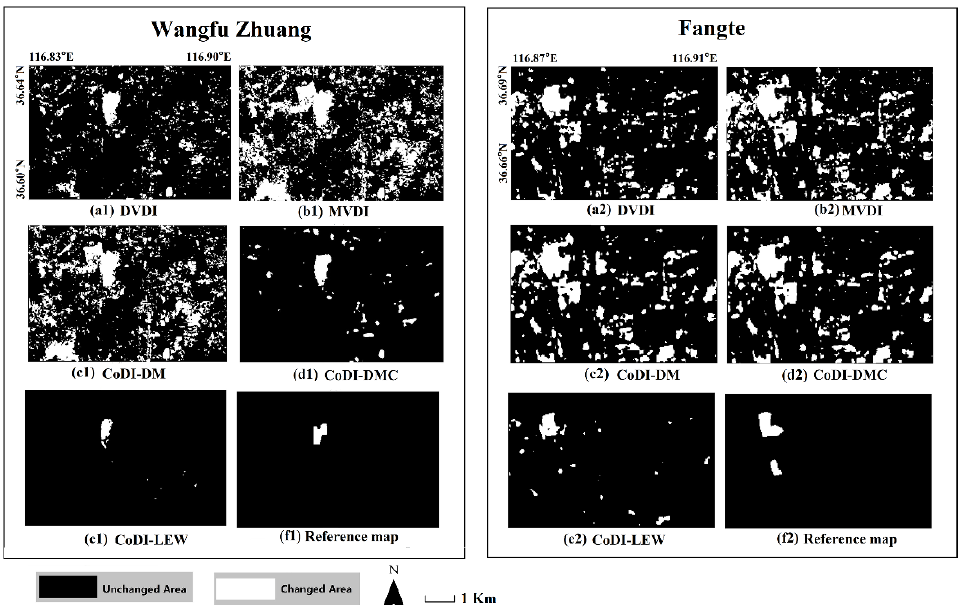
Figure 8. Changed areas detected from multiple difference images around Wangfu Zhuang Station ( a1 – f1 ) and Fangte Station ( a2 – f2 ). Note: ( a , b ) are detected from single difference images of the DVDI and MVDI, and ( c – e ) are detected from combined difference images. The CoDI-DM combines by the DVDI and MVDI with equal weights, the CoDI-DMC combines the DVDI, MVDI and CDI with equal weights and the CoDI-LEW combines the DVDI, MVDI and CDI with local energy weights.